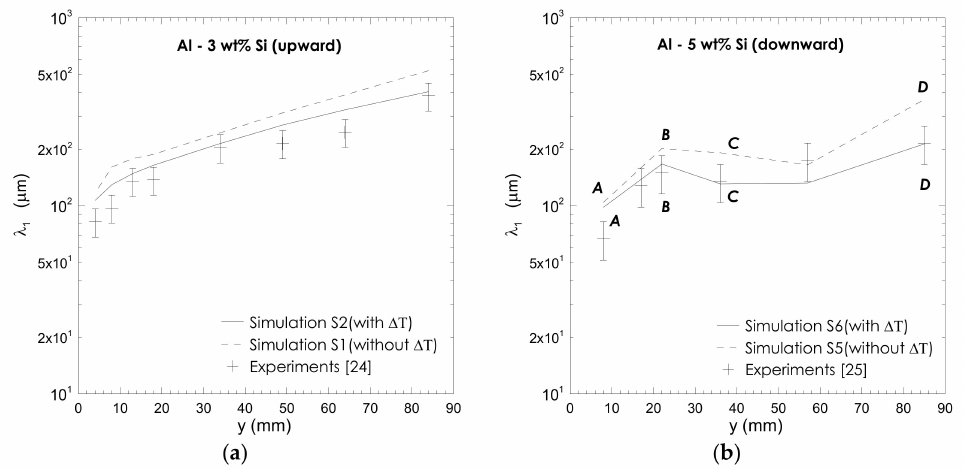
Figure 21. λ 1 distribution at r = 0 mm and y ranged from 8 mm to 84 mm for simulations ( a ) S1 and S2 compared to experiments [18]; ( b ) S5 and S6 compared to experiments